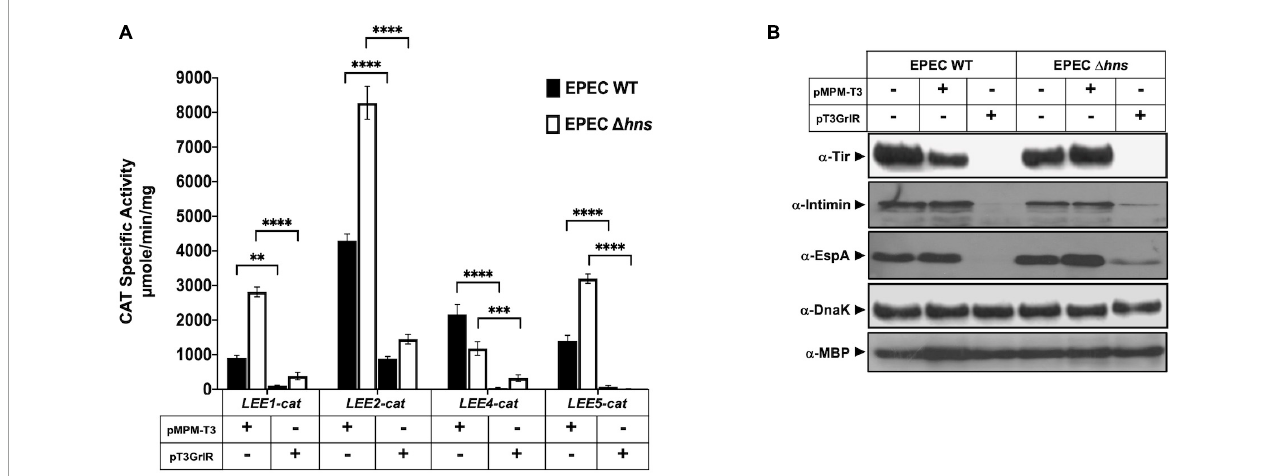
FIGURE2 GrlR represses the expression of locus of enterocyte effacement (LEE) genes in the absence of H-NS. (A) Expression of the LEE1-cat, LEE2-cat , LEE4-cat , and LEE5-cat fusions was analyzed in WT enteropathogenic Escherichia coli (EPEC) (black bars) and its (cid:49) hns isogenic mutant (white bars) carrying the empty vector pMPM-T3 (V) or its derivative pT3GrlR (R), grown in DMEM with shaking at 37 ◦ C. Specific chloramphenicol acetyltransferase (CAT) activity was determined using samples collected from cultures grown in 50 ml Dulbecco’s modified Eagle’s medium (DMEM) or Lysogeny Broth (LB) at an OD 600 of 1. Values are an average of three independent experiments performed in duplicate. Error bars indicate standard deviations. Statistically different values are indicated ( ∗∗ p -value < 0.01; ∗∗∗ p -value < 0.001; ∗∗∗∗ p -value < 0.0001). (B) Total extracts were prepared from the same culture samples and separated by 12% SDS-PAGE. The expression of Tir, intimin and EspA was analyzed by western blotting using polyclonal anti-intimin and anti-EspA and monoclonal anti-Tir antibodies. As controls for protein loading, maltose binding protein (MBP) and DnaK were also detected using monoclonal anti-DnaK and polyclonal anti-MBP